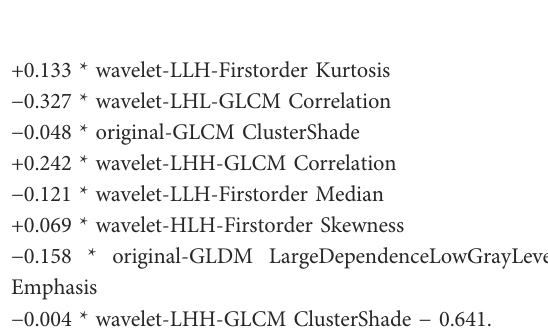
FIGURE 4 The coef fi cients histogram of texture features was selected to predict PLNM. Using the LASSO model, 14 corresponding texture features were selected to predict PLNM.